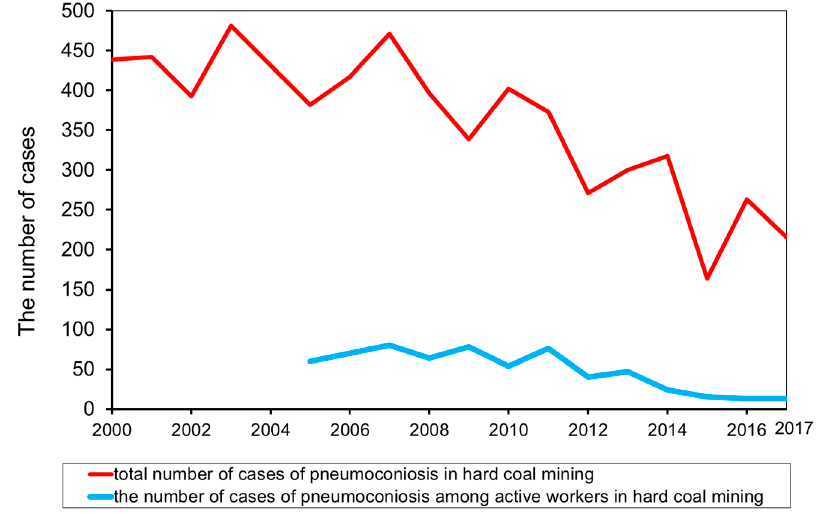
Figure 1. The number of reported cases of pneumoconiosis among workers of hard coal mines in Poland in 2000–2017.